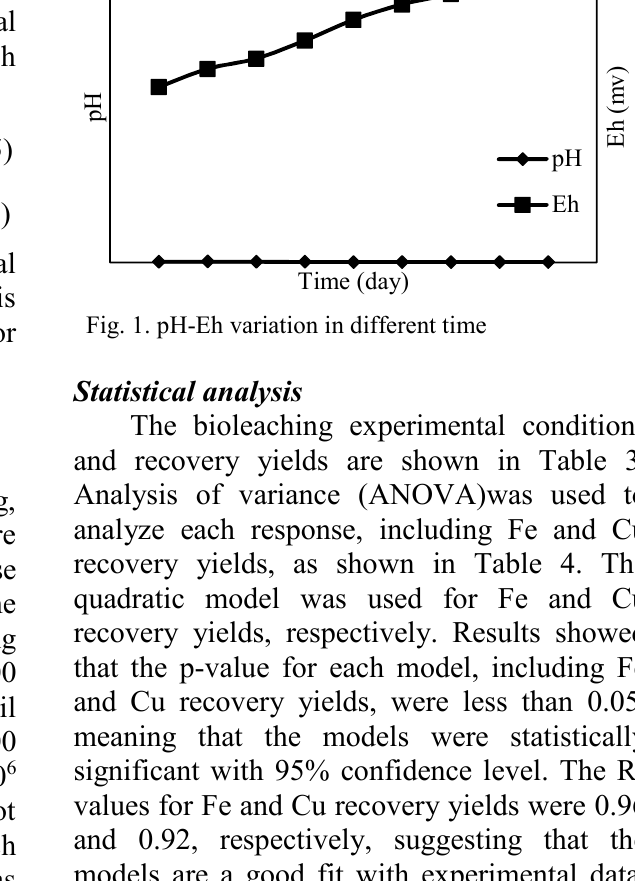
Table 2. Levels of the variables used for experimental design Factor Code Unit Initial pH A - Initial density B g/l00mL 0.5 Initial [Fe 2+ ] C g/L